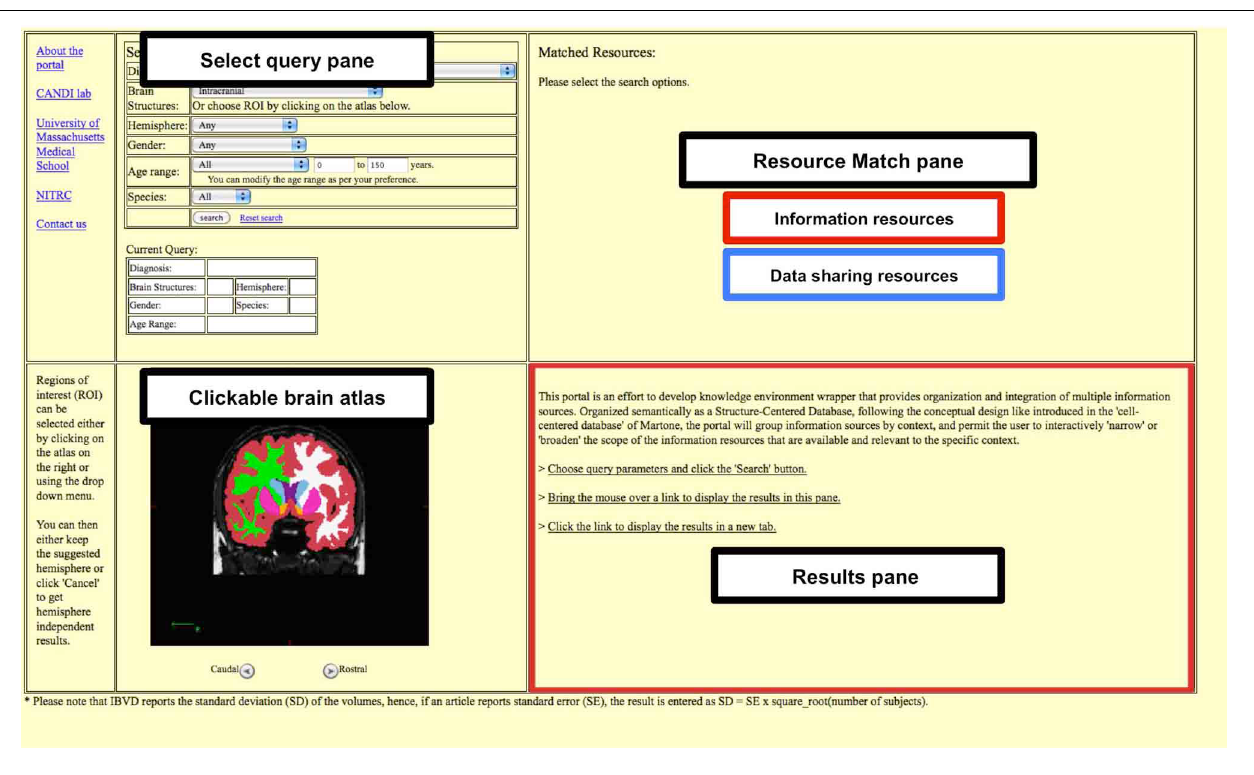
FIGURE 1 | The four pane window format. The portal has a four-pane format consisting of Select Query pane, Clickable brain atlas pane, Resource match pane and the Results pane. The Research match pane displays any